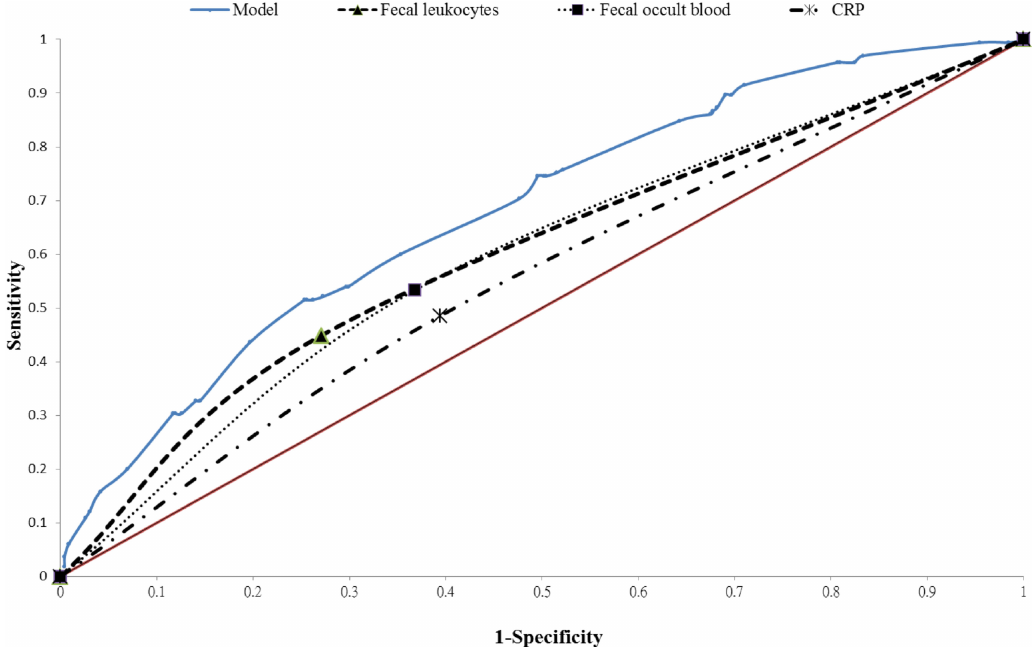
Figure. Receiver operating characteristic (ROC) curve for the ancillary test. The area under the ROC curve is 0.681 for our model, 0.589 for fecal leukocytes, 0.583 for fecal occult blood, and 0.546 for CRP